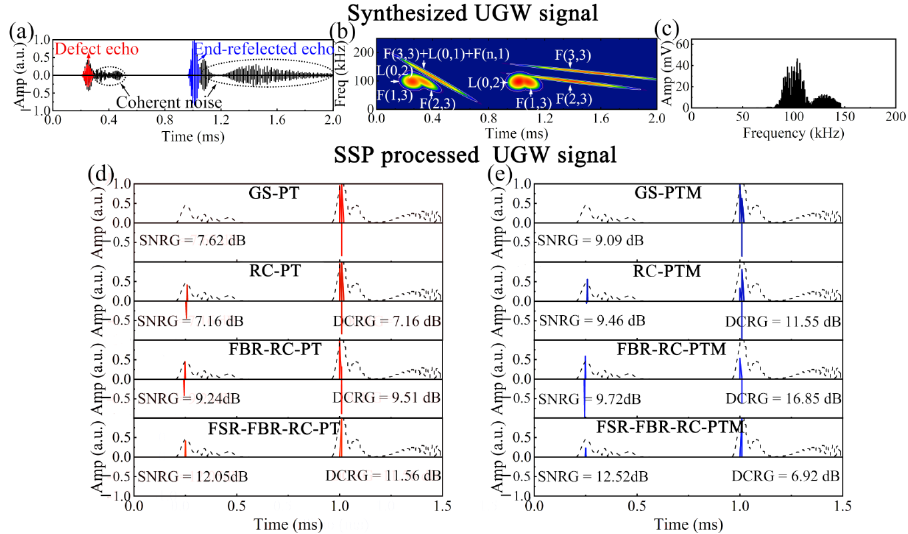
Figure 6. Synthesized UGW signals in the ( a ) time, ( b ) time-frequency, and ( c ) frequency domains, sparse signals processed by ( d ) SSP-PT and ( e )